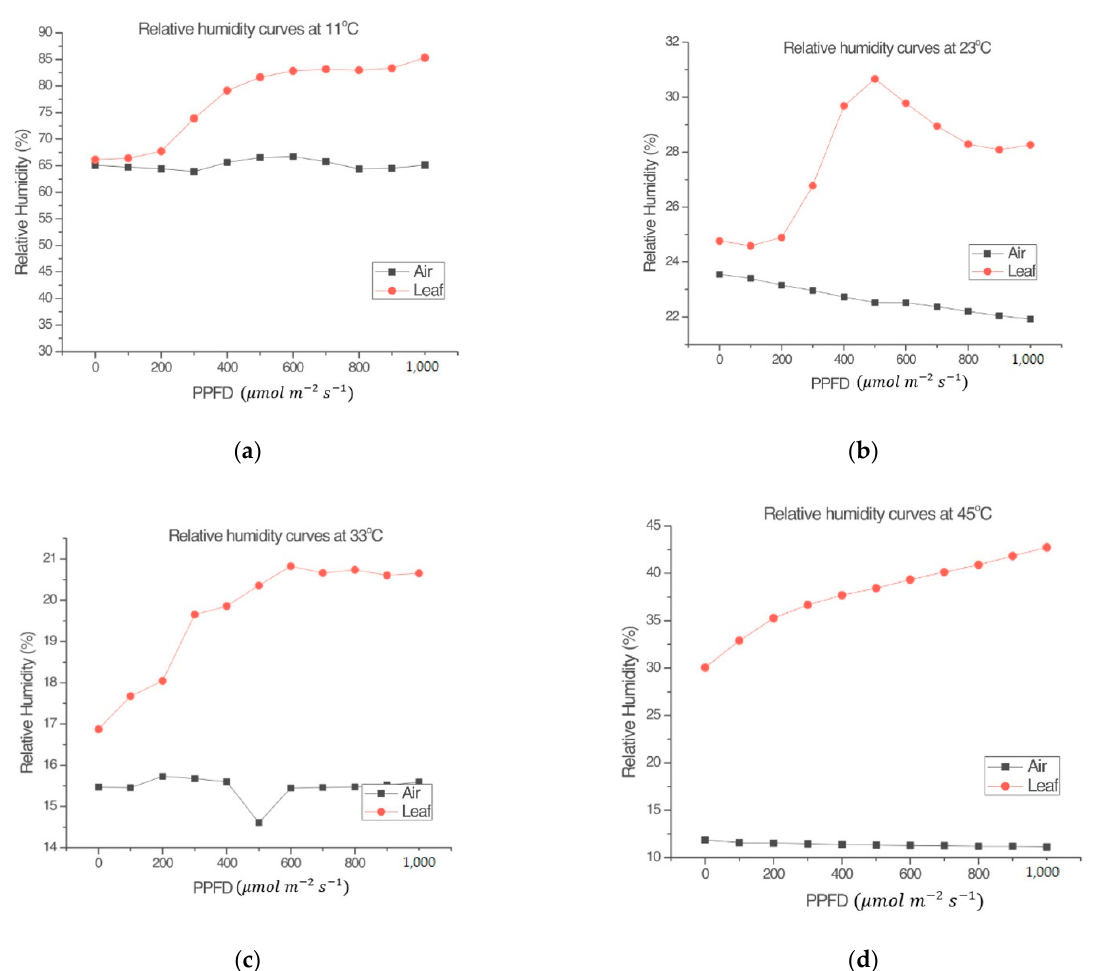
Figure 3. Comparison between the relative humidity of the air ( RH a ) in the environmental test cham- ber and the relative humidity of the leaf ( RH l ) inside the measuring chamber of the LI-COR Li-6800, at different air temperatures in the environmental test chamber. ( a ) 11 °C, ( b ) 23 °C, ( c ) 33 °C, and ( d ) 45 °C. Experimental organism: Capsicum annuum L .